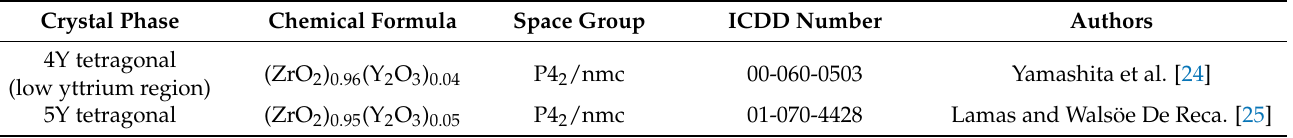
Table 4. ICDD cards used for refinement of the